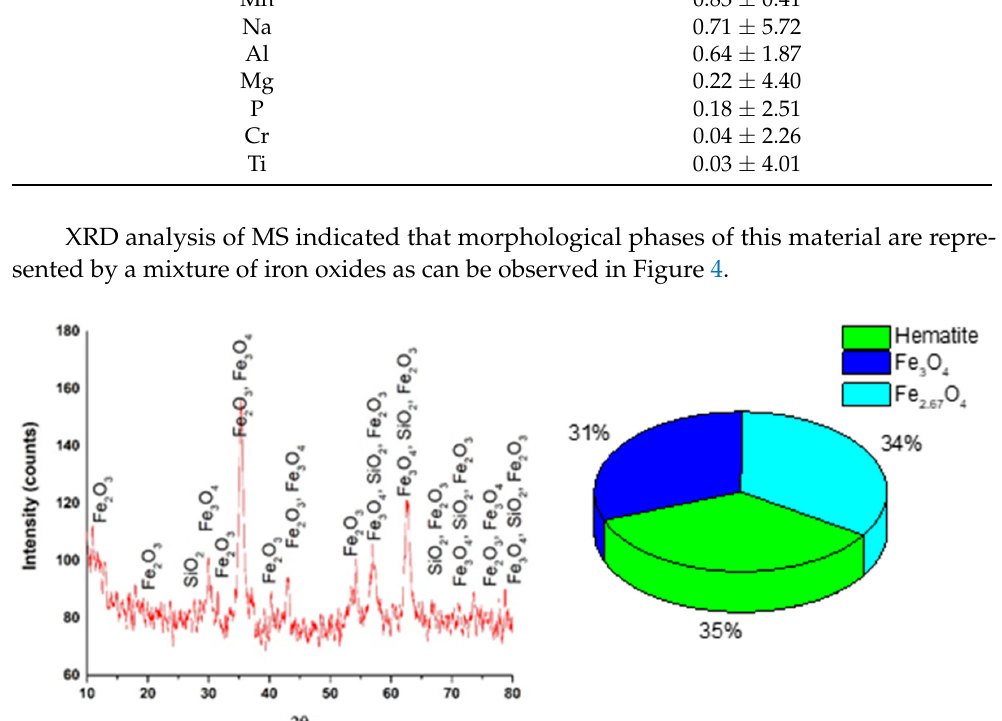
Figure 5. SEM image of the MS powder at 10,000 × and EDX associated. 3.2. Characterization and Composition of MS-ION After acidic dissolution and evaporation/drying steps, a white-yellow solid material resulted, which was used as a precursor (ION-MS). XRD spectra (Figure 6) indicated that acidification converted MS into a complex major phase as Fe 4 S 5 O 21 , according to the ICSD data sheet. This compound is characteristic of MS-ION as an intermediate product for ION preparation. The crystallite size was calculated using Equation (1) and was about 75 nm. Figure 7 presents the SEM-EDX observations performed on the MS-ION material. Particles are agglomerated, with a well-defined elongated aspect. In addition to these shapes, there are small and rounded particles of about 200 nm. This size is in accordance with the small crystallite size of the particles generated by the Debye-Scherrer equation; the SEM observations indicate the agglomeration of these crystallites. The round shape is characteristic of powders obtained by a ball grinding process. According to the EDX image, the major elements are Fe, S and O, which compares well with the XRD spectra. In order to establish Fe speciation from the MS-ION precursor, a traceability analysis method was developed, which combined XRF and AAS techniques. The results obtained are presented in Table 2. For 1.95 g MS dissolved in warm water, an average percentage of 77% Fe could be estimated. This quantity is in accordance with re- sults indicated in Table 1 for MS analyzed by XRF. This indicated that the initial Fe content was maintained and a ratio of 1:4 ( w / w ) of Fe(II): Fe(III) was available as a mixture in the MS-ION precursor. The total Fe concentration (sum of Fe(II) and Fe(III)) analyzed using the AAS tech- nique corroborated with the XRF analysis and spectrophotometry technique and indi- cated that about 20% represents Fe(II). With this information, according to the general